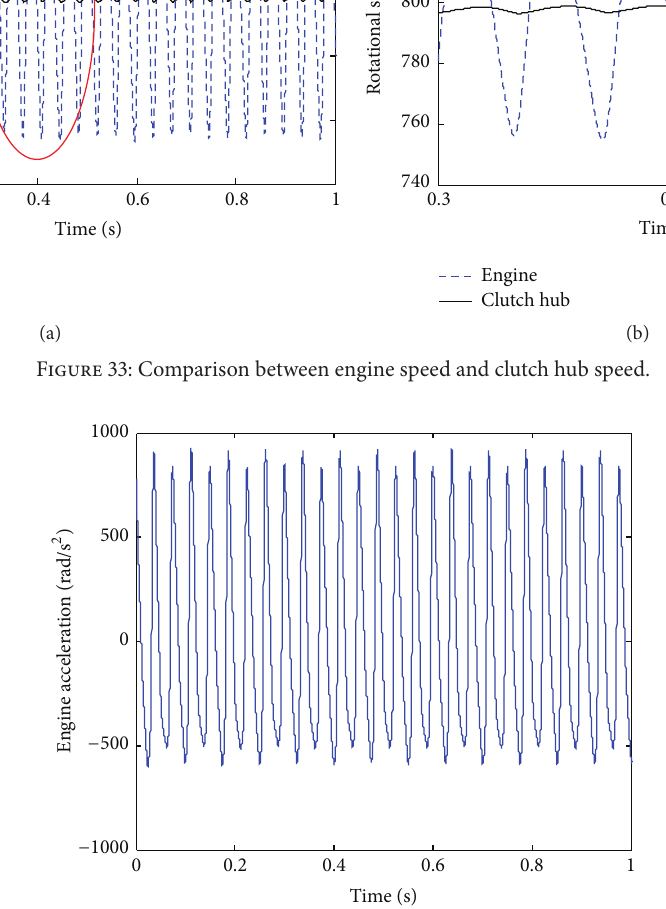
Figure 34: Angular acceleration of the